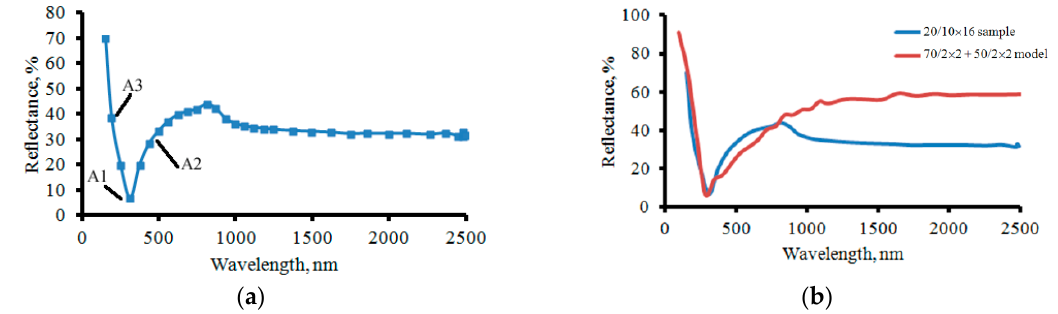
Figure 8. The choice of characteristic points on sample 5 (2 BL) reflection spectrum ( a ); the comparison of the experimental (blue line) and optimised reflection spectrum (brown line) after computer modelling ( b ).